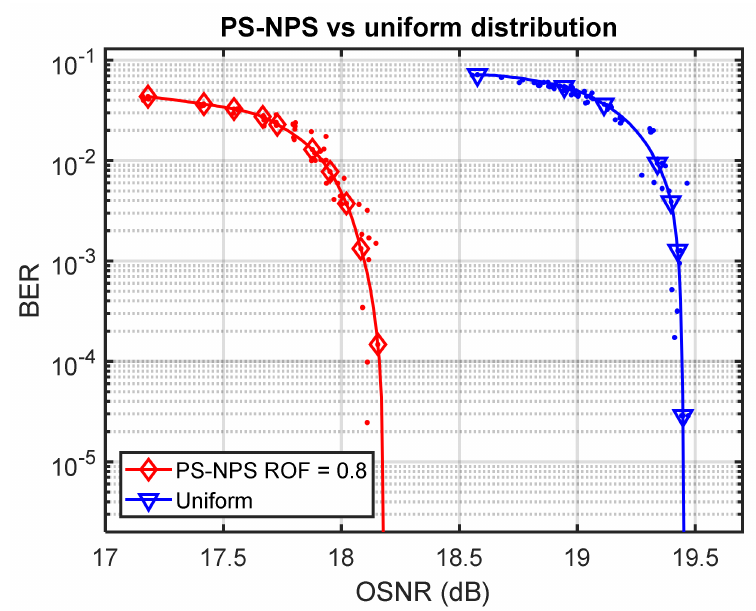
Figure 8. BER performance of an LDPC-coded PS-NPS-8-PAM against an LDPC-coded uniform